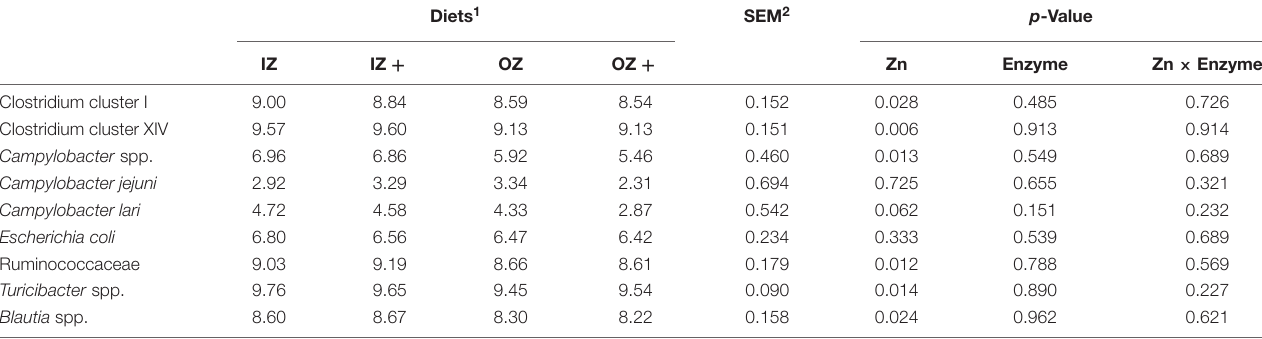
TABLE 5 | Log 10 DNA copies per g of feces collected from dogs fed diets supplemented with inorganic (IZ and IZ + ) and organic (OZ and OZ + ) Zn sources without (IZ and OZ) and with (IZ + and OZ + ) the addition of a multi-enzymatic complex from the solid-state fermentation of Aspergillus niger . Diets 1 SEM 2 p -Value